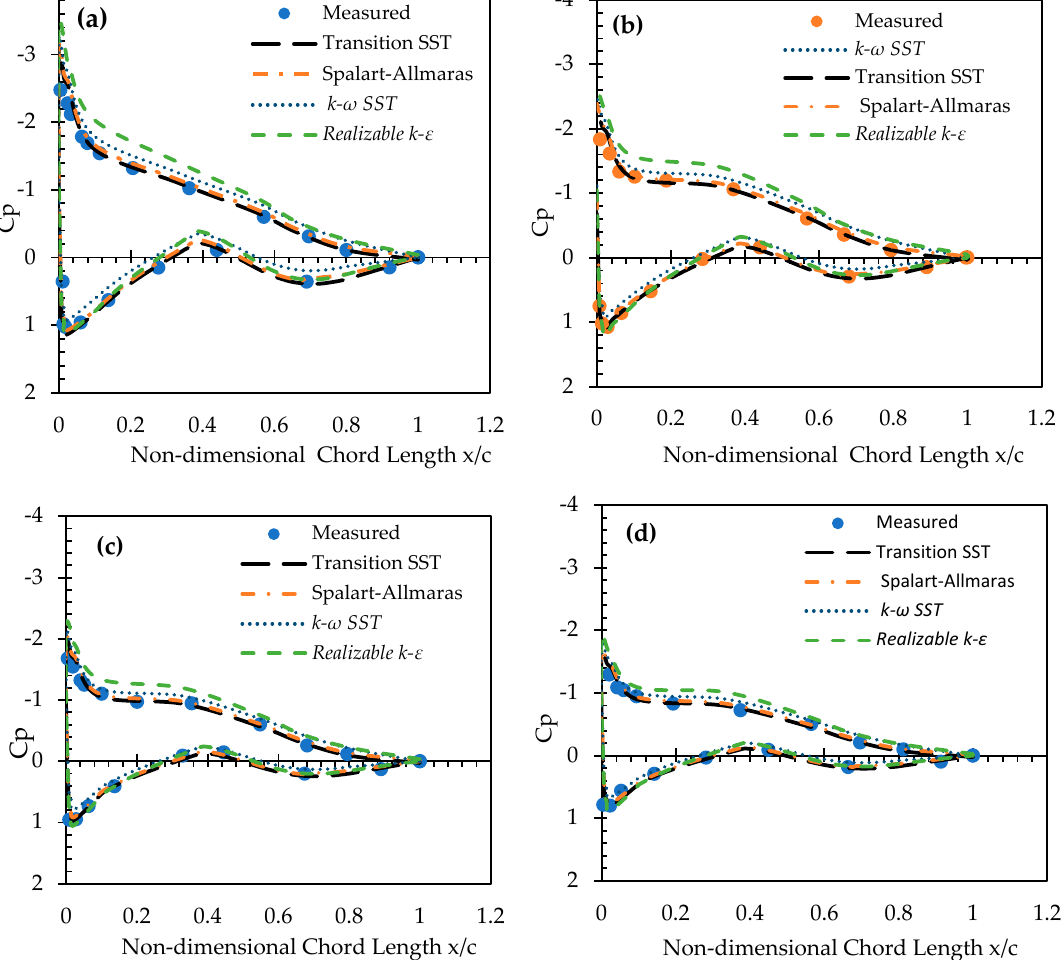
Figure 7. Comparison of span-wise pressure distribution among the di ff erent turbulence models and NREL measurements at 7.2 m / s for: ( a ) 47% section, ( b ) 63% section, ( c ) 80% section, and ( d ) 95% section.